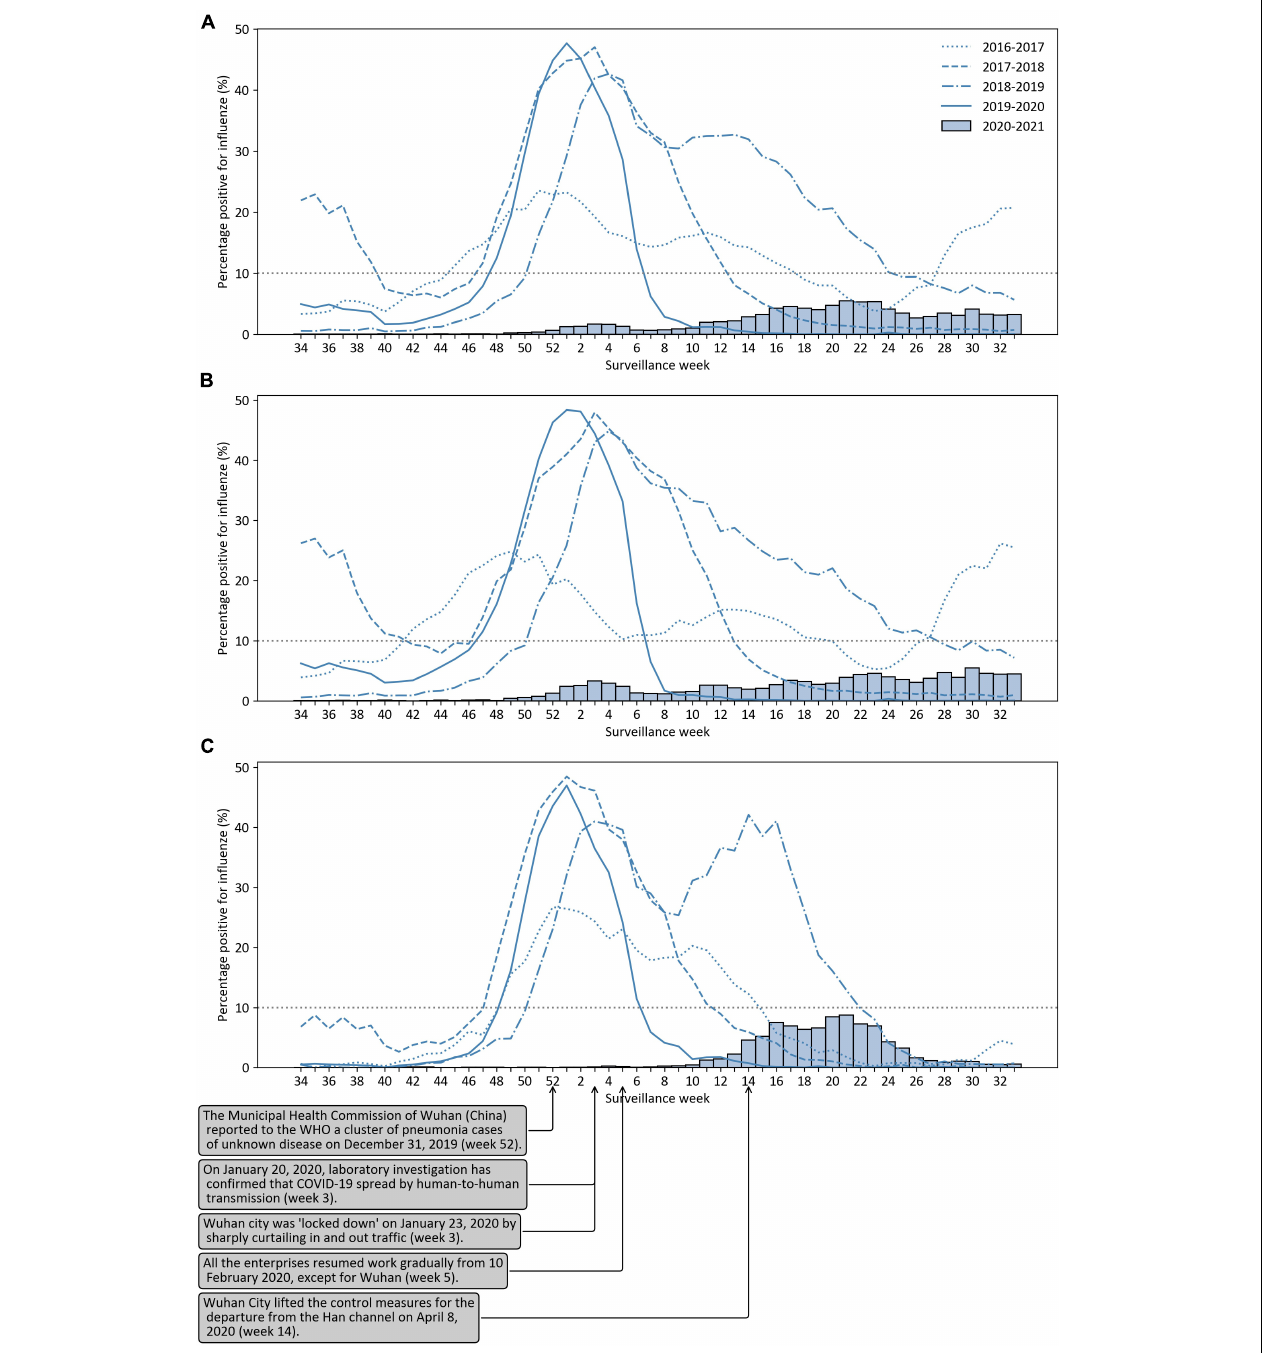
FIGURE 1 | The percentage of positive tests for influenza viruses in the 2016–2017 through 2020–2021 seasons. (A) For mainland China; (B) For southern China; (C) For northern China.